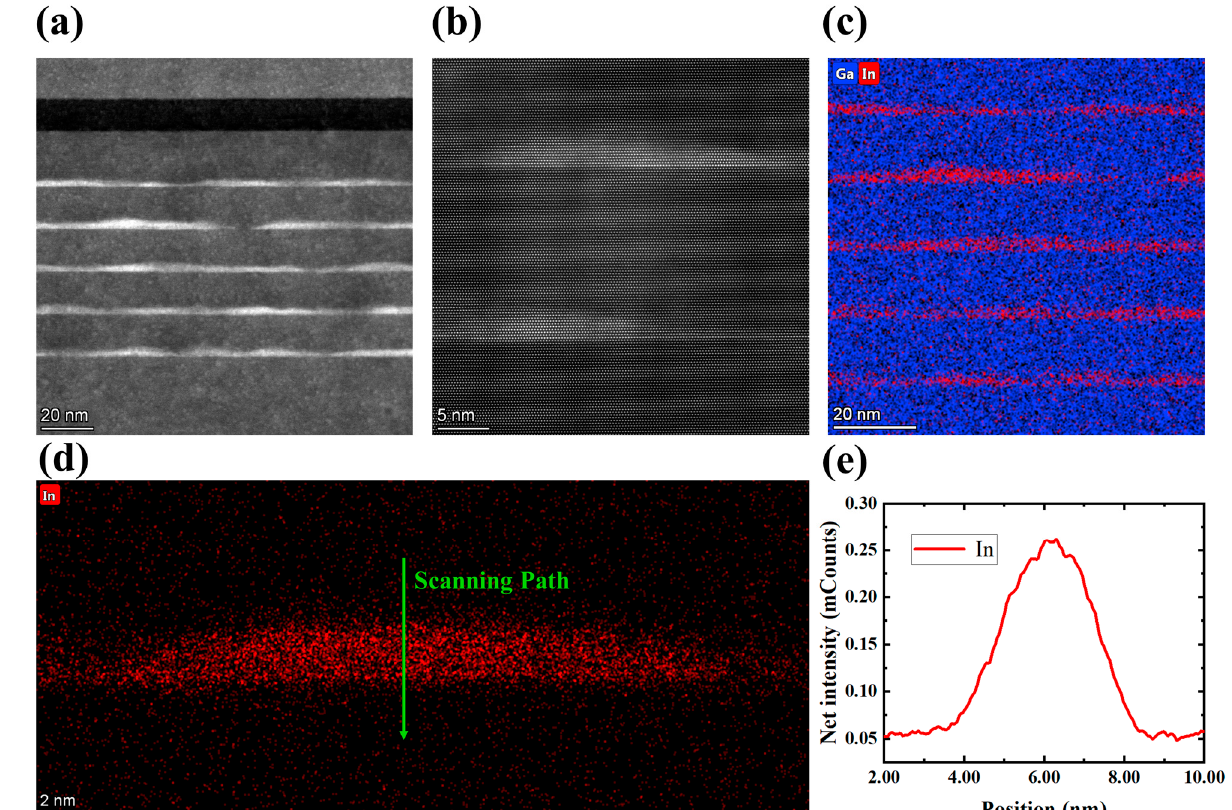
Figure 3. ( a ) Cross-sectional TEM image of InGaN/GaN MQDs in LED wafer; ( b ) enlarged local TEM image of InGaN QDs; ( c , d ) EDS mapping image of Ga and In element; ( e ) In element line scanning of the InGaN QD along the green arrow line.